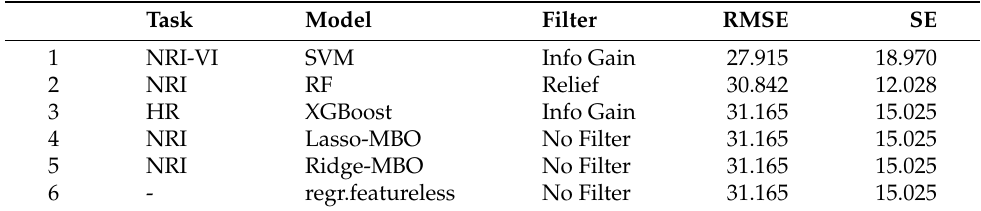
Table 3. The overall best individual learner performance across any task and filter method for RF, SVM, XGBoost, lasso, and ridge, sorted ascending by RMSE (p.p.) including the respective standard error (SE) of the cross-validation run. For extttregr.featureless, the task is not applicable and was therefore removed.